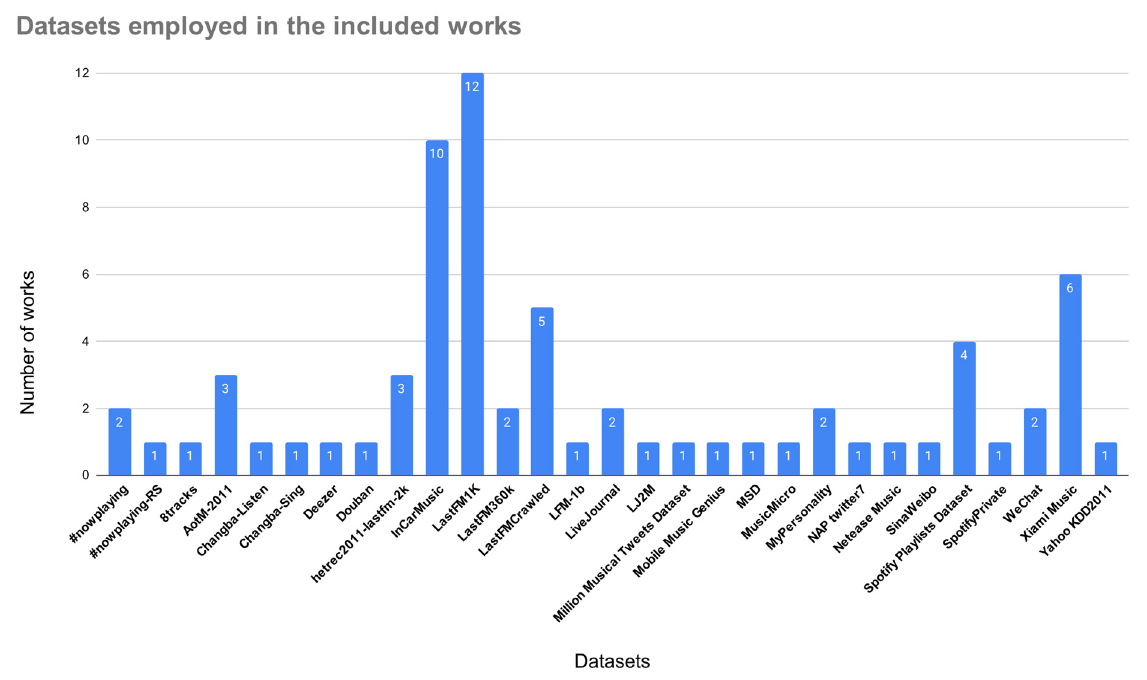
Figure 7. Amount of works which employ each dataset.